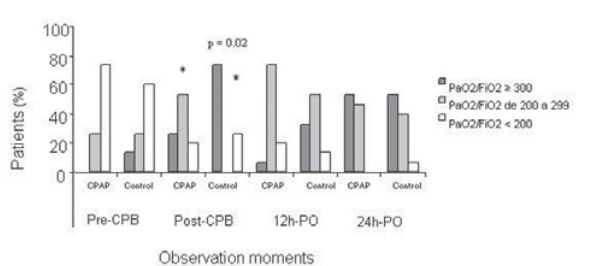
Fig. 4 - PaO /FiO (mmHg) at different observation times in both 2 2 groups. - Statistically significant difference was found in the /FiO between 200 e percentage of patients that has shown PaO 2 2 300 at Post-CPB in the CPAP group in relation to control group. (* p = 0.02). CPB = cardiopulmonary bypass; Pre = pre-CPB; Post- CPB = 30min post-CPB; 12hPO = 12h postoperative; 24h-PO